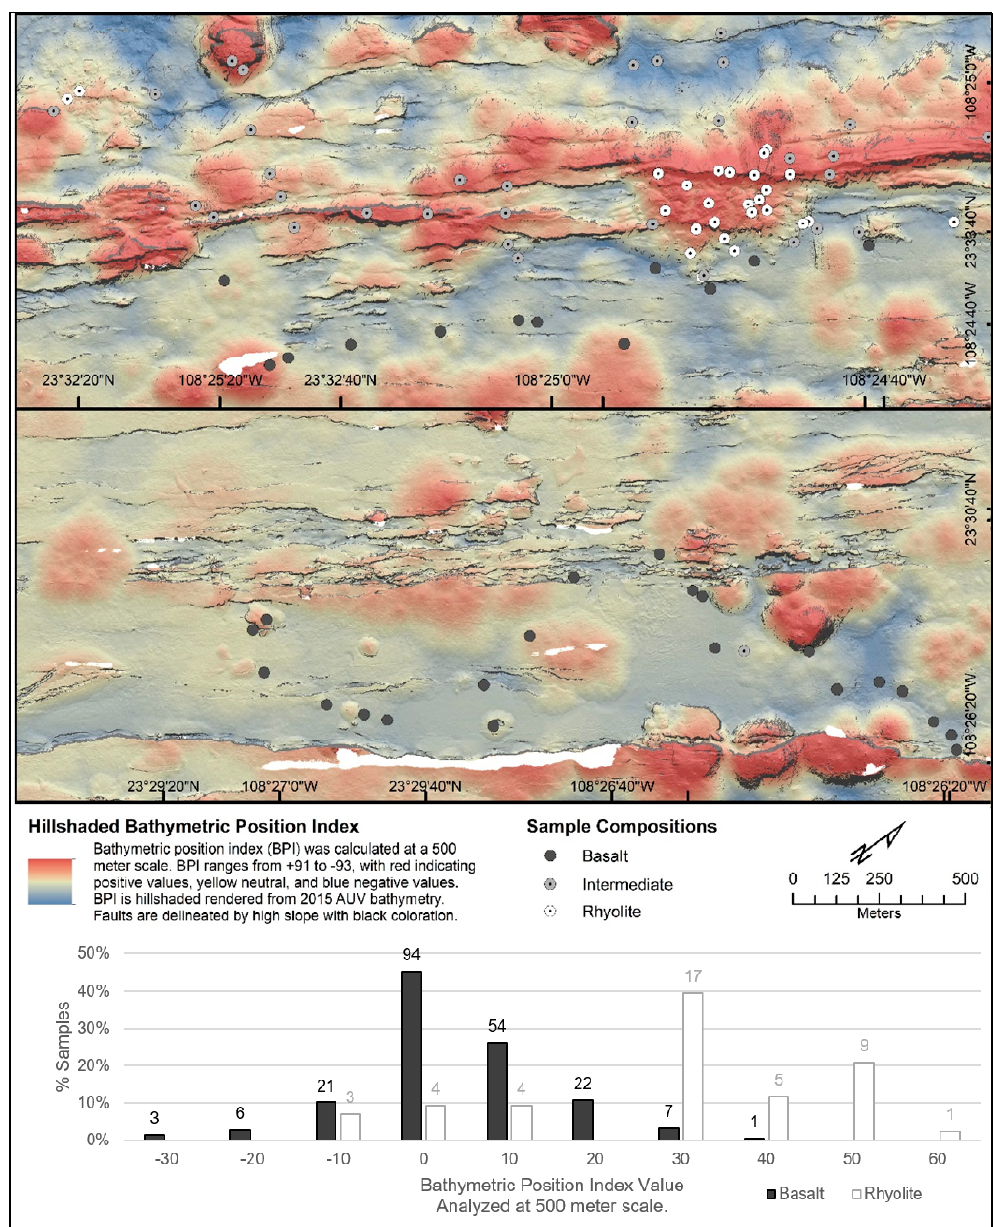
Figure 7. Bathymetric position index (BPI) values at the 0.5 km scale at the Alarcon Rise for two examples within the North AOI (top panel) and to the south of that region (middle panel) to illustrate a mainly basaltic flows and the rhyolitic area. Basalt samples from flat terrain about a zero value with a few basalts collected on isolated pillow mounds resulting in a high BPI value (bottom panel). Most rhyolitic samples had high BPI values.